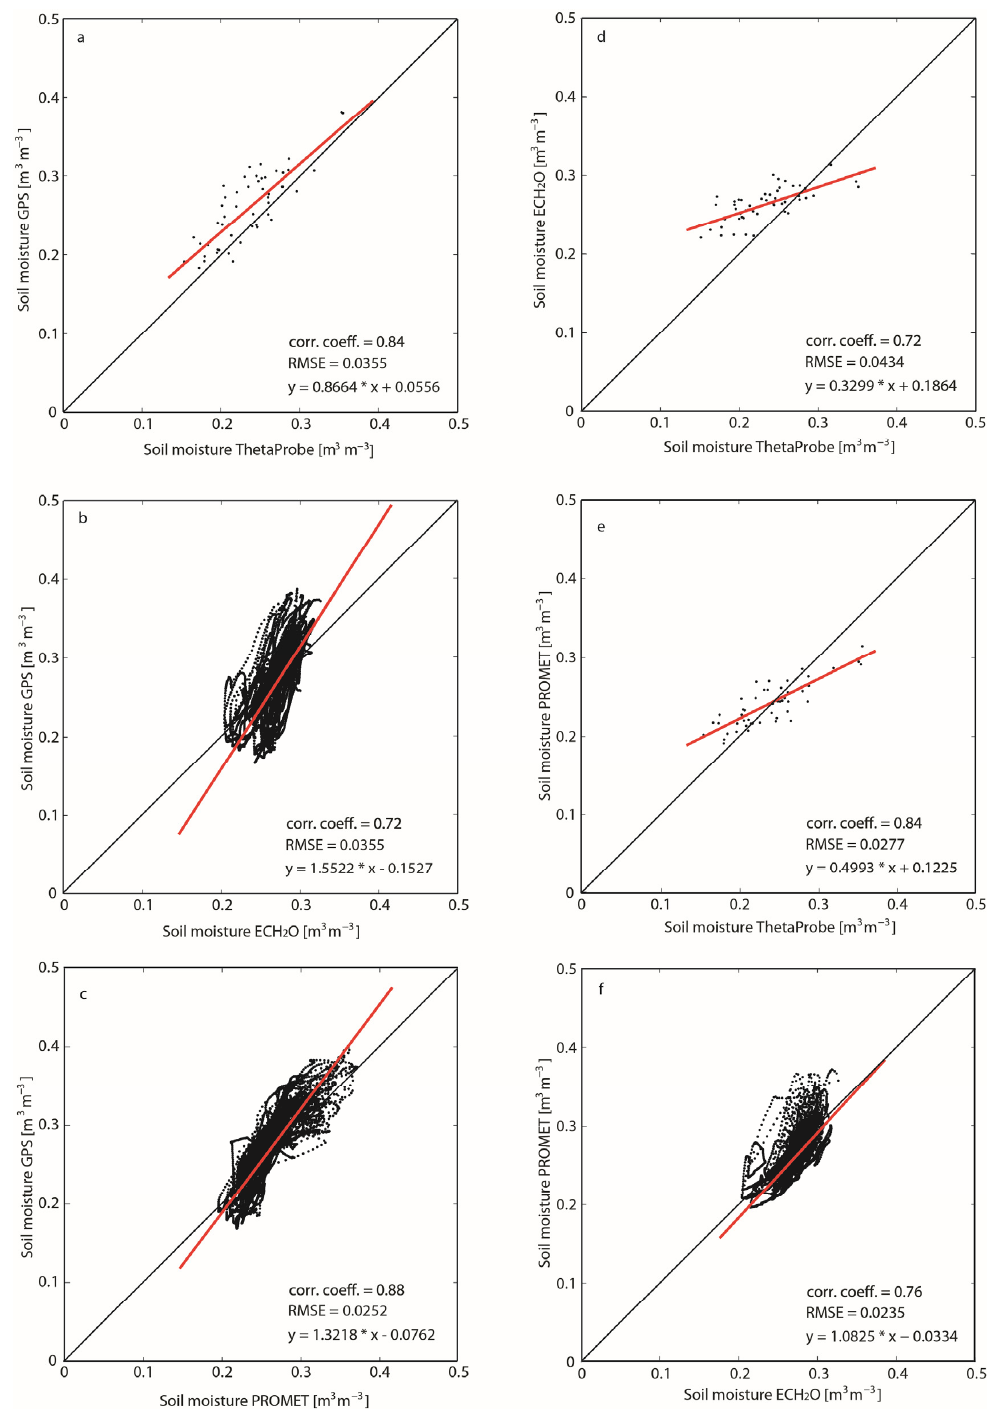
Figure 5. Comparison of soil moisture values ( a ) measured by ThetaProbe vs. measured by GPS; ( b ) measured by ECH 2 O vs. measured by GPS; ( c ) modelled with PROMET vs. measured by GPS; ( d ) measured by ThetaProbe vs. measured by ECH 2 O; ( e ) measured by ThetaProbe vs. modelled with PROMET and ( f ) measured by ECH 2 O, vs. modelled with PROMET at the DWD test site in Munich during the measurement period 1 January 2014–10 June 2015.